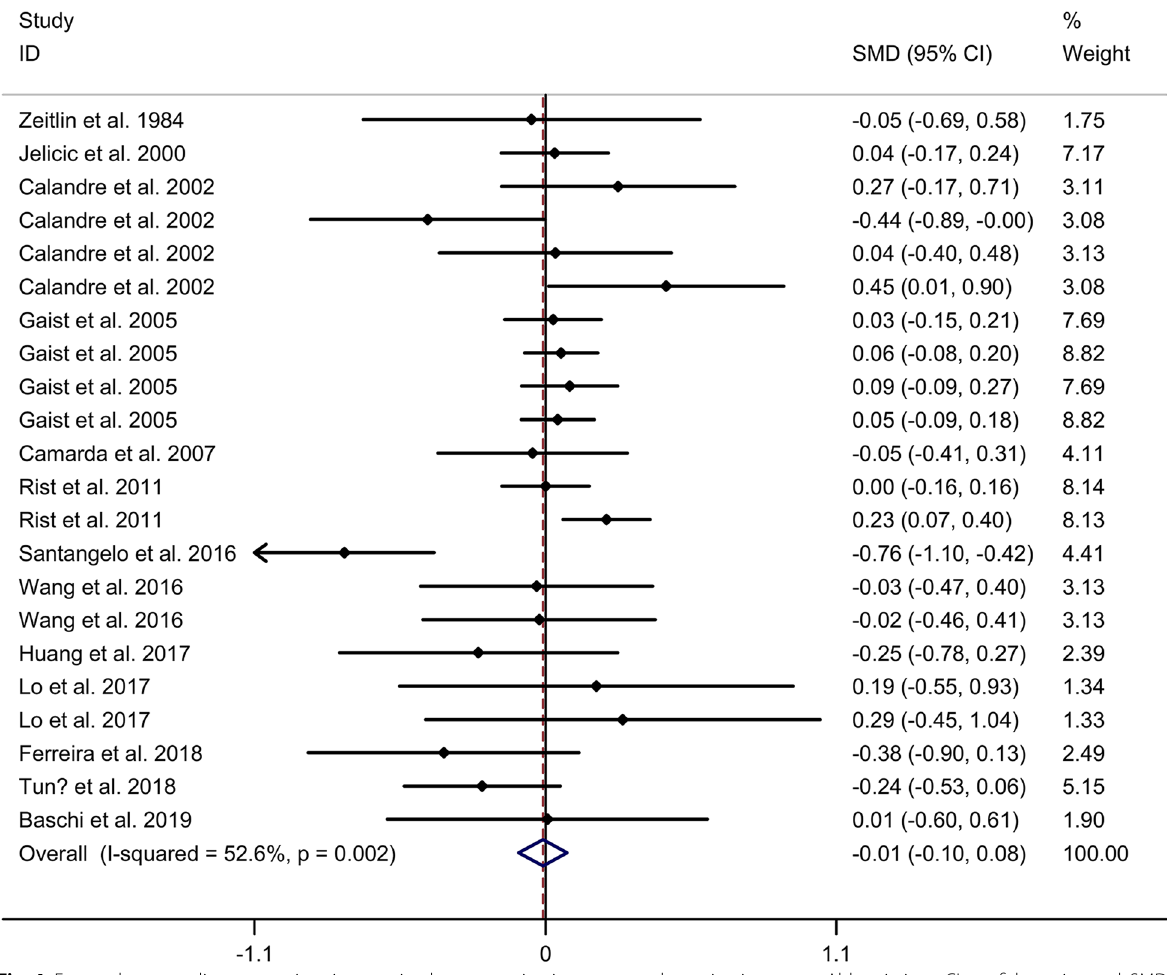
Fig. 4 Forest plots regarding comparison in attention between migraine group and no migraine group. Abbreviations: CI, confidence interval; SMD, standard mean